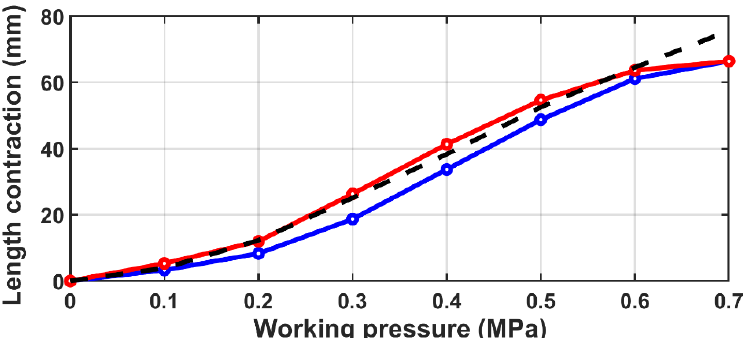
Figure 15. Diagram of correlation between the length contraction and working pressure for m = 7.5 kg: dashed line for theoretical modeling, blue line for experimental results of lifting a load, red line for experimental results of lowering a load